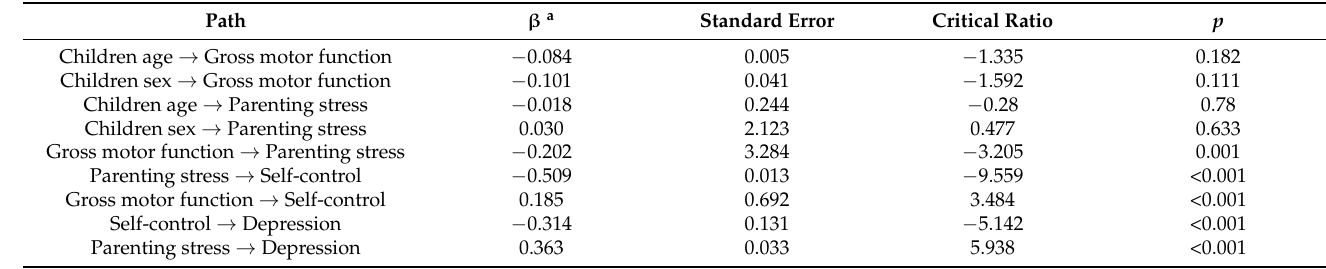
Table 4. Path coefficients of the conceptual